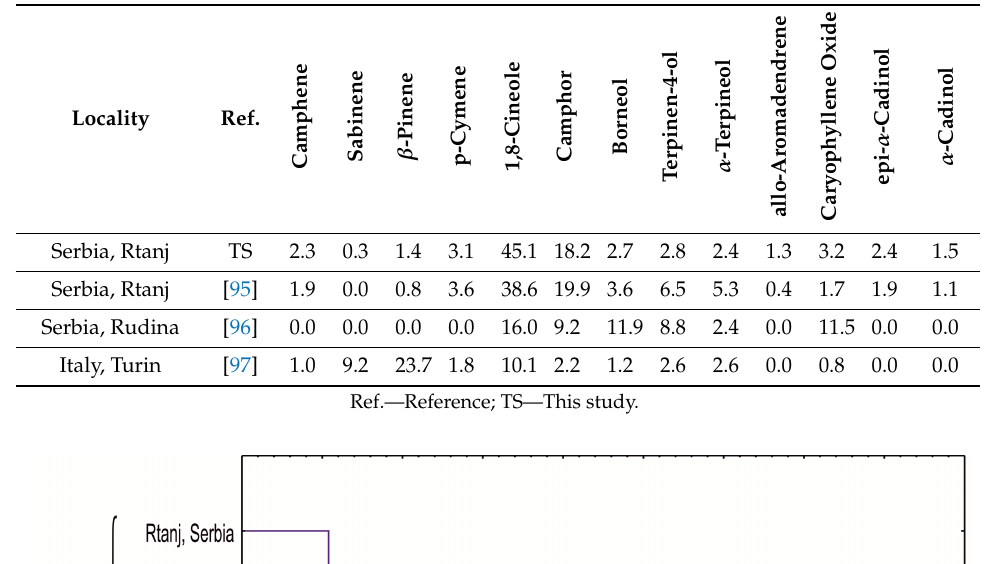
Table 7. A. clypeolata EO constituents from this study and others reported previously in the literature.